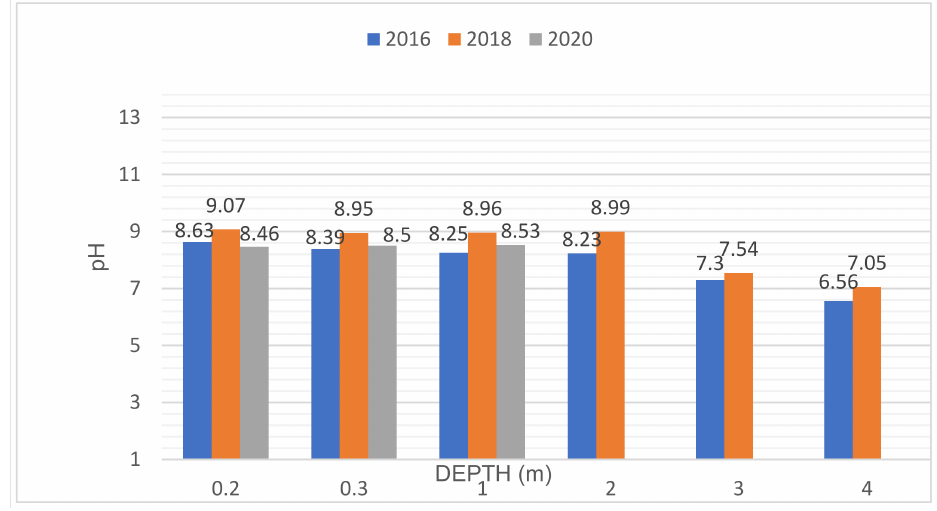
Figure 7. pH levels at several depths of Lake